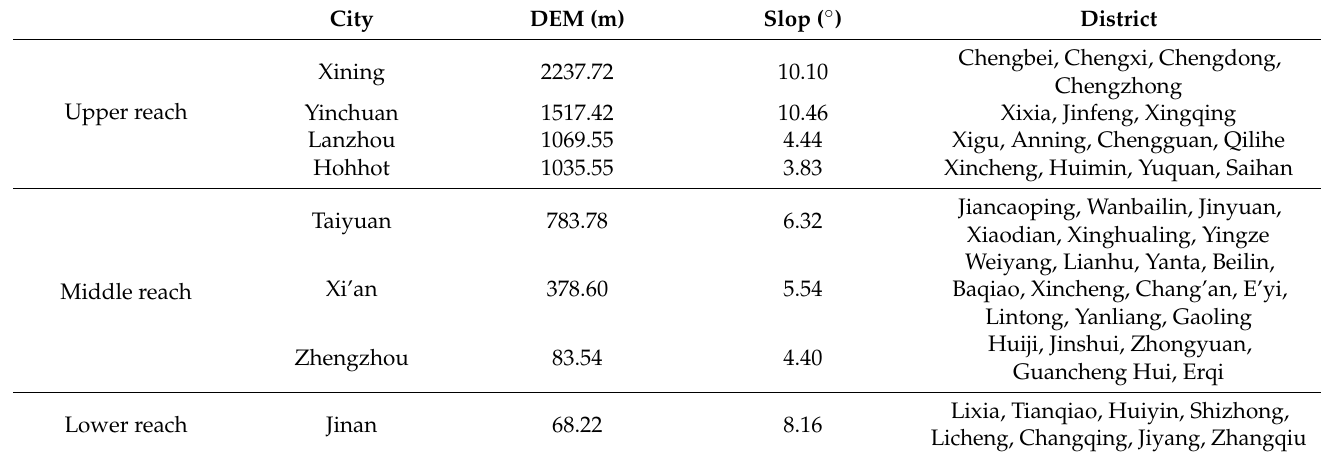
Table 1. The districts of each provincial capital in the Yellow River Basin.